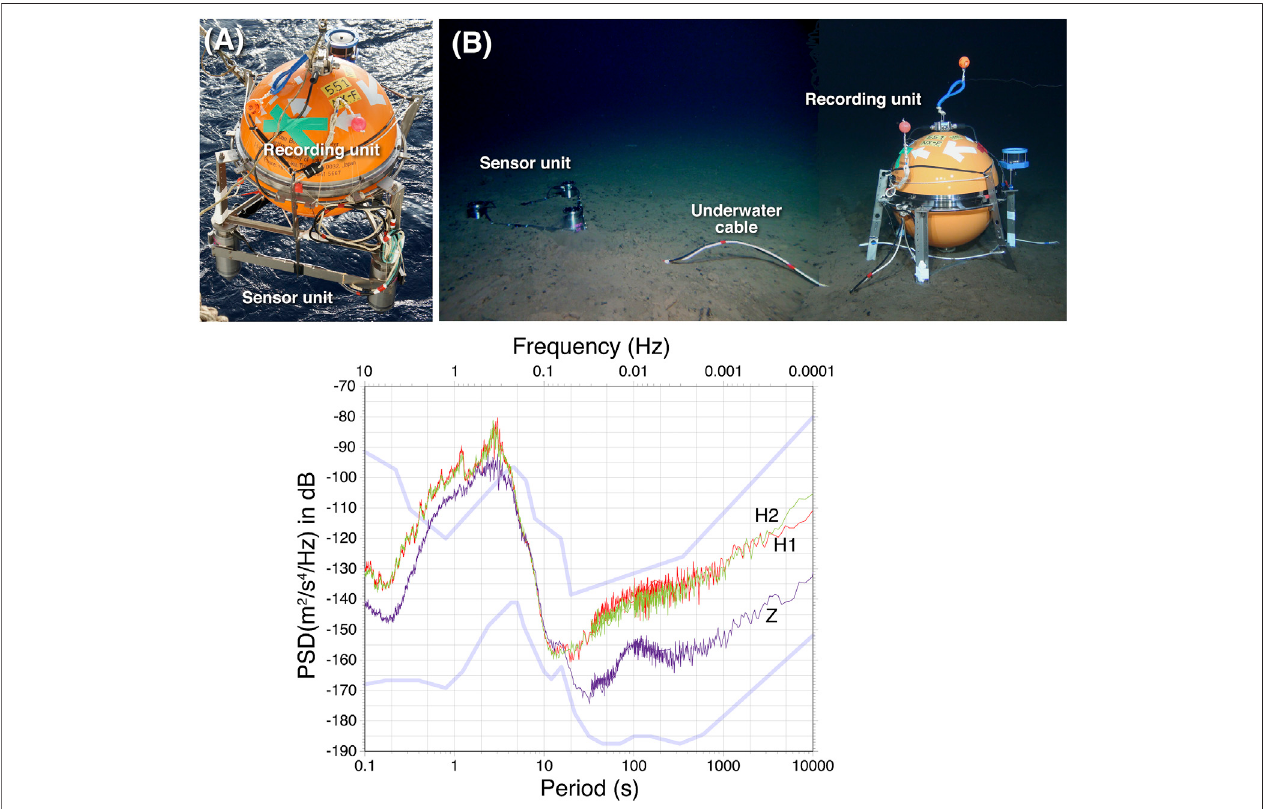
FIGURE3| TheBBOBS-NX.TheBBOBSwiththepenetratorsensorsystemusinggravity. ROVoperationisrequiredindeployment andrecovery.Thebroadband sensor has the same performance of the BBOBS. (A) The sensor unit and the recording unit are temporally attached, and free-fallen from the sea surface. Descending speedisabout1.5 m/s. (B) TheyaredetachedandtherecordingunitismovedafewmetersawayfromthesensorunitbytheROV.Theobservation periodcanbemore than 2 years. (C) An NM example of the BBOBS-NX. Because of the penetration of the sensor unit, all three component NMs are between the NHNM and the